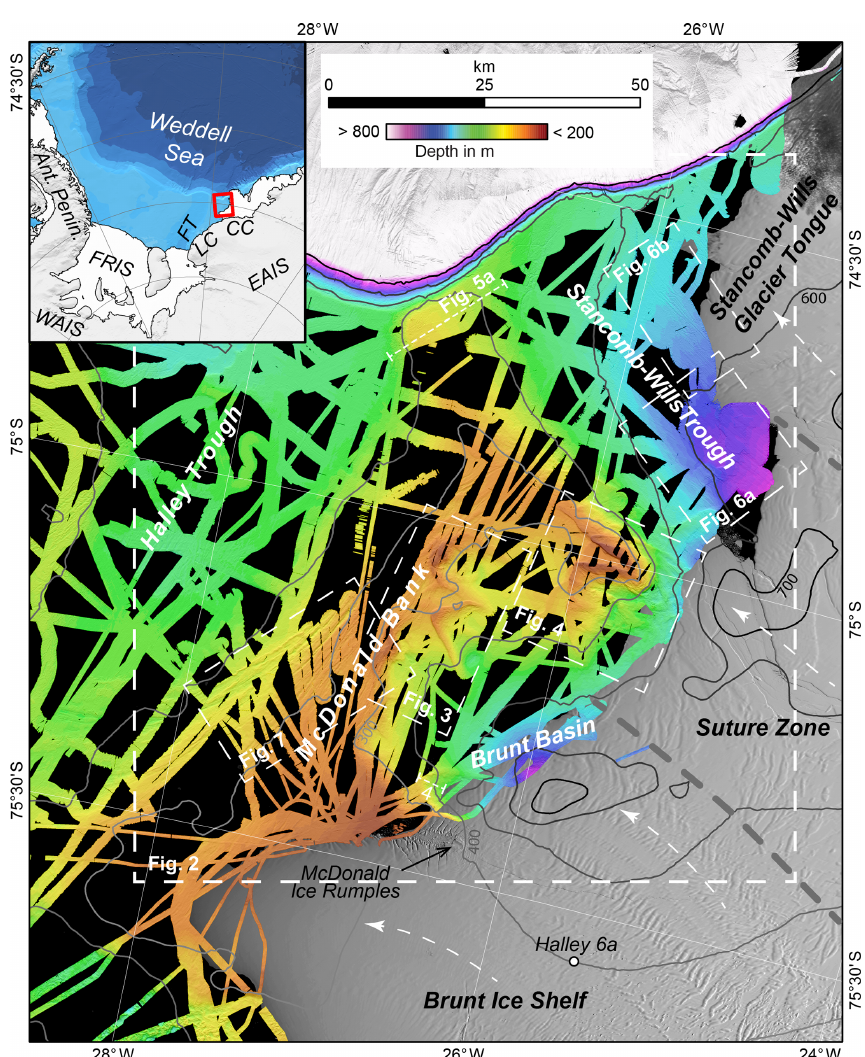
Figure 1. Overview map of the study area showing color-coded high-resolution bathymetric data and geographic locations mentioned in the text. Greyscale contour lines are in 100m intervals from the IBCSO V1.0 data set (Arndt et al., 2013). Background satellite image is from Landsat, courtesy of the US Geological Survey. Locations of other figures and two bathymetric cross profiles, shown in Fig. 5, are indicated by dashed rectangles and lines, respectively. The inset map shows the study area in a broader Antarctic context (background from Arndt et al., 2013). CC stands for Caird Coast, EAIS stands for East Antarctic Ice Sheet, FRIS stands for Filchner–Ronne Ice Shelf, FT stands for Filchner Trough, LC stands for Luitpold Coast, and WAIS stands for West Antarctic Ice